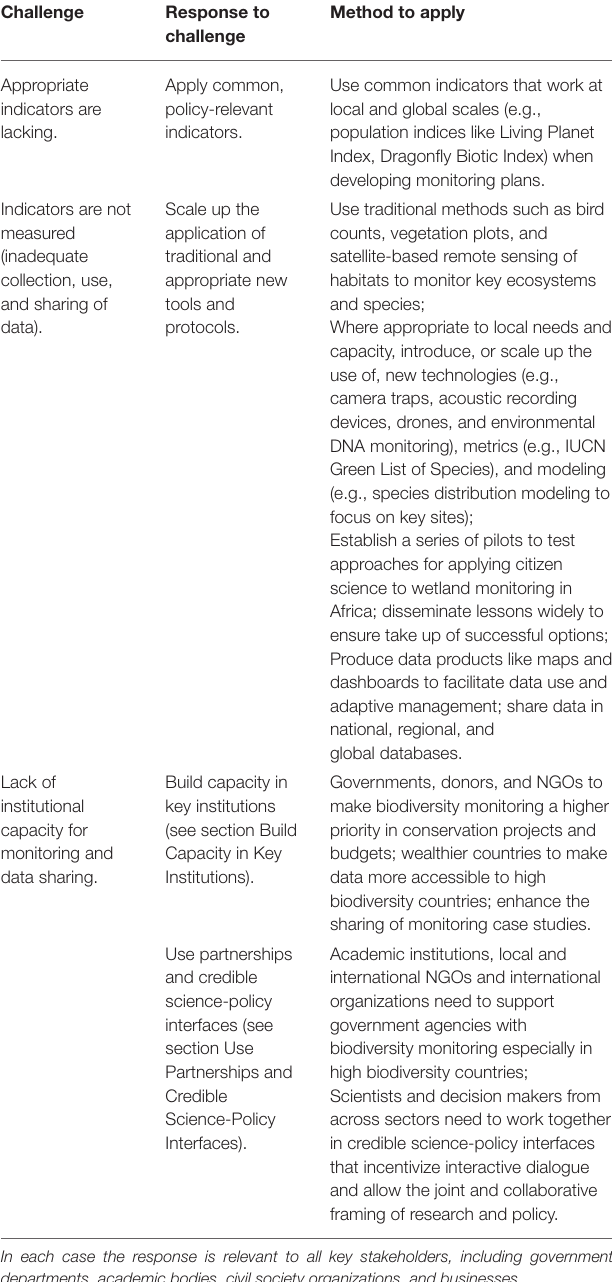
TABLE 1 | Summary of responses needed to tackle the challenges with wetlands biodiversity monitoring in